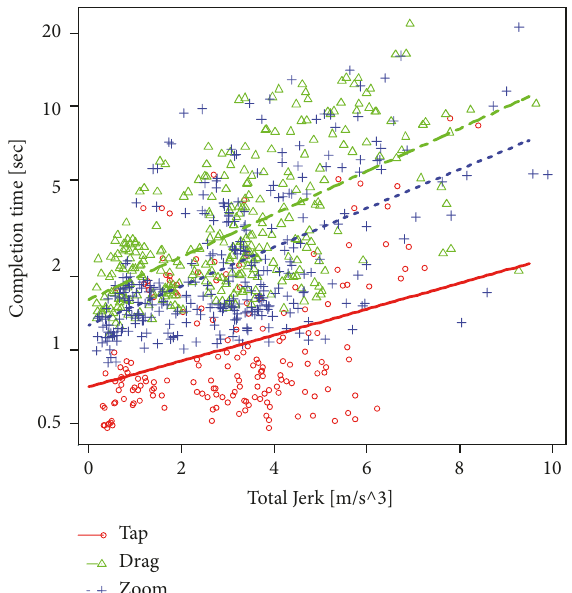
Figure 17: Evolution of the task completion time when jerk in- creased and other parameters were kept at their mean value. Loga- rithmic scale.